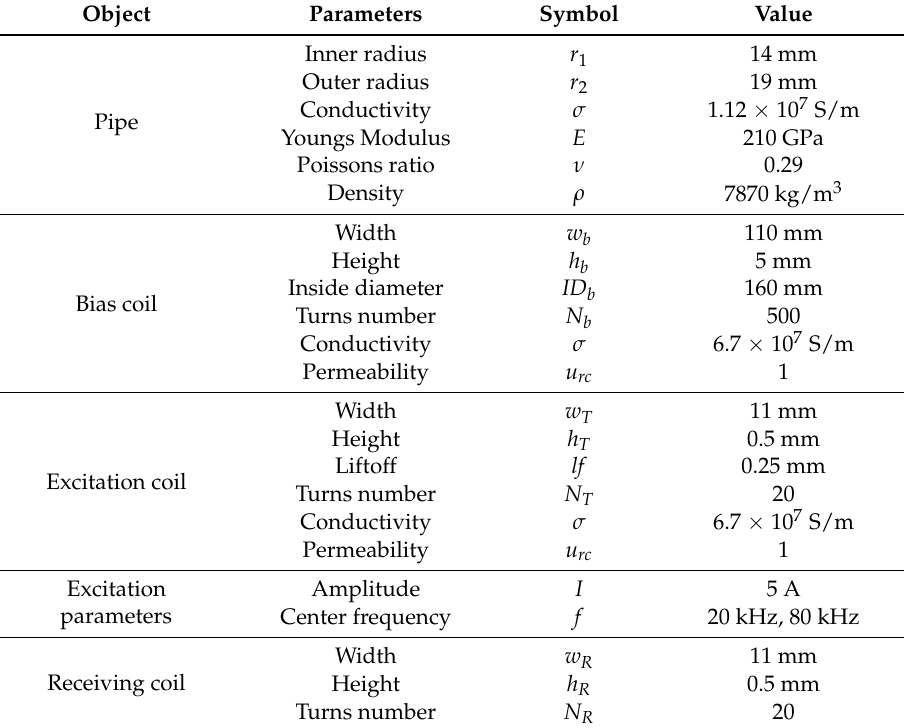
Table 1. Parameters of the FE model used in this work.